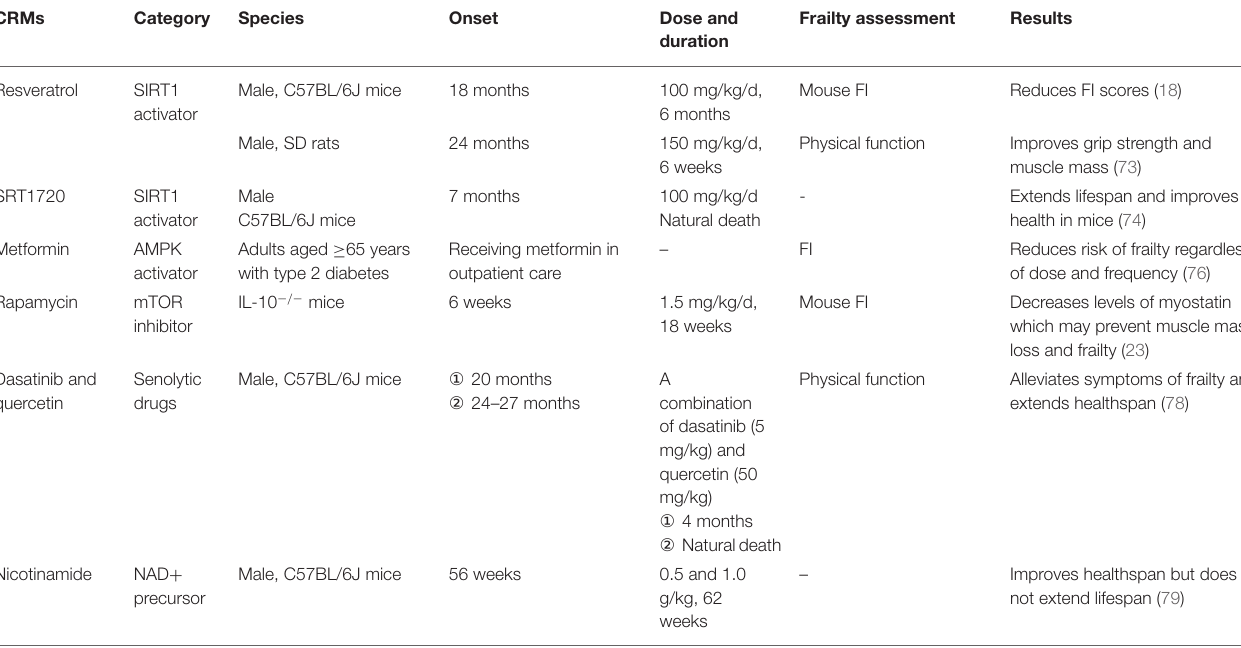
TABLE 1 | Caloric restriction mimetics and frailty